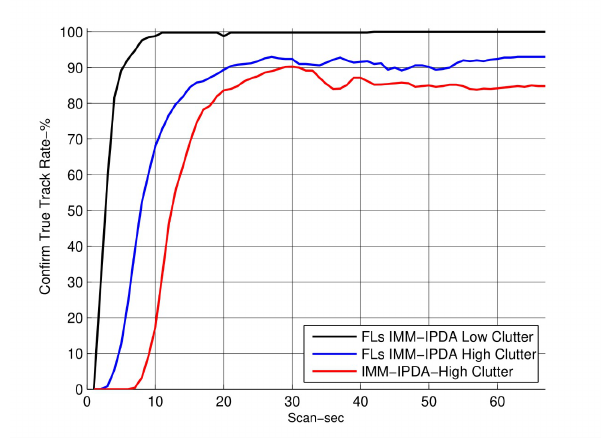
Figure 10. True track rate for clutter density: 2 × 10 − 4 m − 2